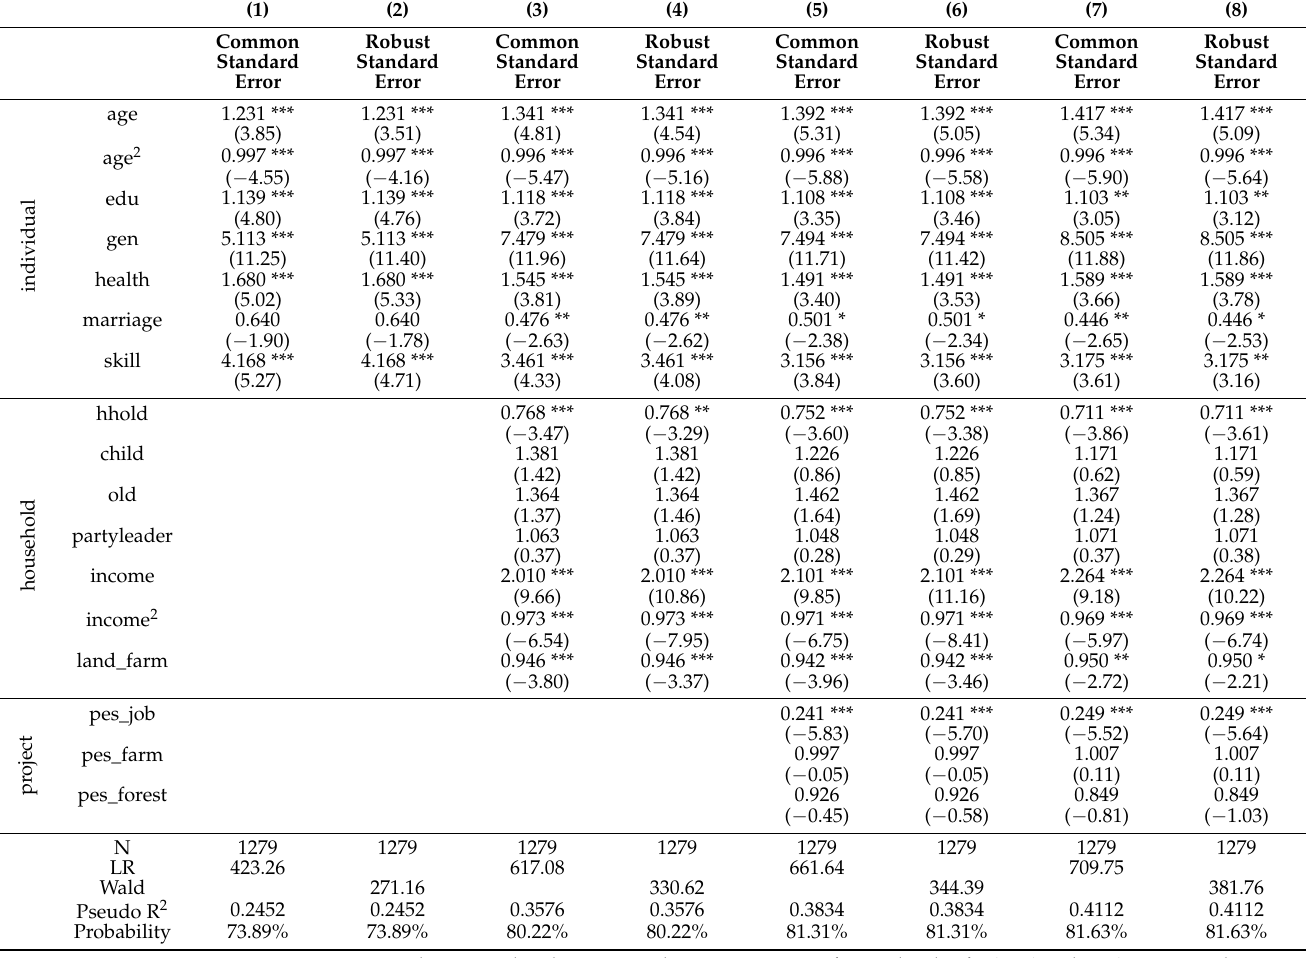
Table 2. Estimation results of the impact of ecological compensation project on rural labor transfer employment by the binary Logit